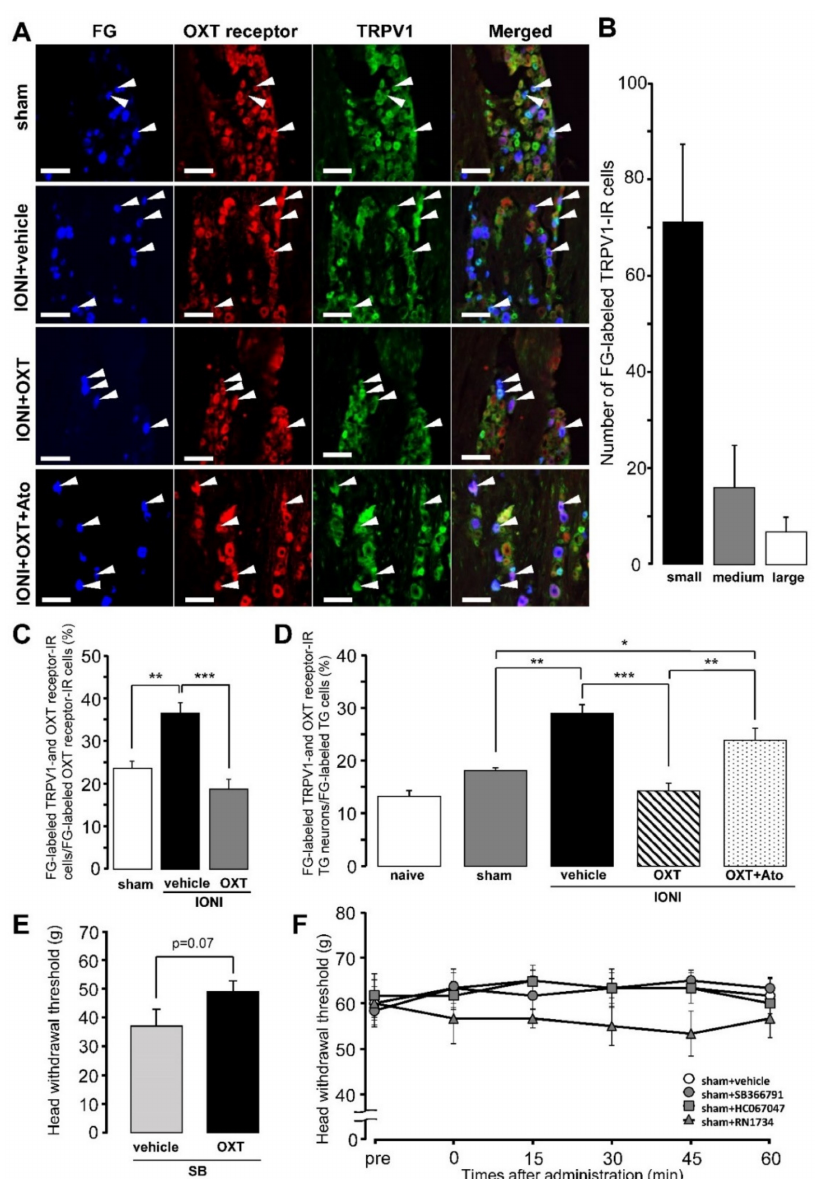
Figure 3. Transient receptor potential vanilloid 1 (TRPV1) and oxytocin (OXT) receptor expression in trigeminal ganglion (TG) neurons on day 5 after sham treatment or infraorbital nerve injury (IONI). ( A ) TRPV1- and OXT receptor-immunoreactive (IR) TG neurons innervating the whisker pad skin on day 5 after sham treatment or IONI with vehicle, OXT, or OXT + atosiban administration. Arrowheads indicate fluoro-gold (FG)-labeled TRPV1- and OXT receptor-IR neurons. Scale bar: 100 µ m. ( B ) Number of FG-labeled TRPV1-IR TG neurons on day 5 after sham treatment. ( n = 4 in each group). ( C ) Mean percentages of FG-labeled TRPV1- and OXT receptor-IR TG neurons out of FG-labeled OXT receptor-IR TG neurons on day 5 after sham or IONI treatment with vehicle or OXT administration. (sham, n = 5; IONI + vehicle, n = 4; IONI + OXT, n = 5). ** p < 0.01., *** p < 0.001. ( D ) Mean percentages of FG-labeled TRPV1- and OXT receptor-IR TG neurons in FG-labeled TG neurons on day 5 after sham treatment or IONI with vehicle, OXT, or OXT + atosiban administration. (naive, n = 5; sham, n = 6; IONI + vehicle, n = 4; IONI + OXT, n = 5; IONI + OXT + Ato, n = 6). * p < 0.05, ** p < 0.01, *** p < 0.001. ( E ) The head withdrawal threshold for mechanical stimulation (MHWT) following coadministration of SB366791 and OXT or vehicle to the ligated site of the ION on day 5 after IONI treatment (IONI with SB366791 and vehicle, n = 5; IONI with SB366791 and OXT, n = 5). ( F ) The MHWT of the whisker pad skin after vehicle, SB366791, HC067047, and RN1734 administration on day 5 after sham treatment ( n = 6 in each